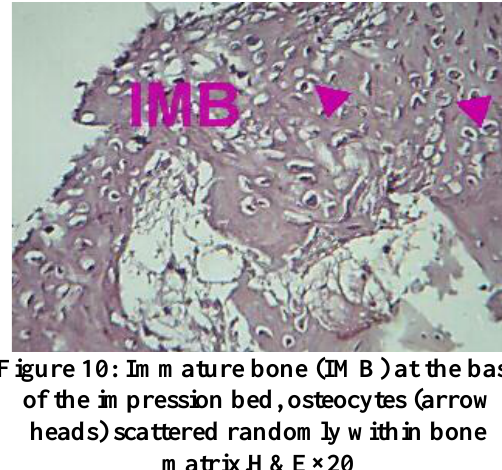
Figure 10: Immature bone (IMB) at the base of the impression bed, osteocytes (arrow heads) scattered randomly within bone matrix.H&E×20 The coated implants at 4 weeks show interdigitation of opposing threads of implant impression and the bone surface surrounded by osteoblast. The base of implant impression close to basal bone filled by bone trabeculae and the osteocyte easily detected as shown in figure 11.